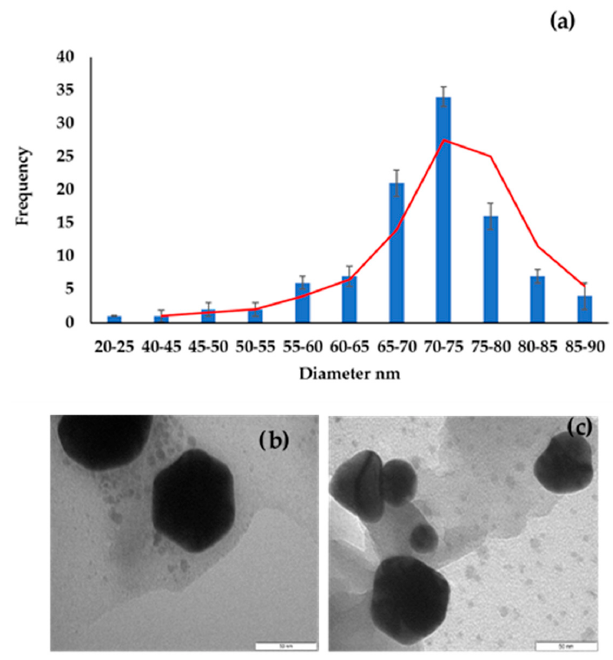
Figure 4. ( a ) Histogram obtained by measuring the diameter of AuNPs; ( b , c ) HRTEM images of tri ‐ sodium citrate AuNPs with the ( d ) zetasizer and ( e, f ) selected area of electron diffraction (SAED).